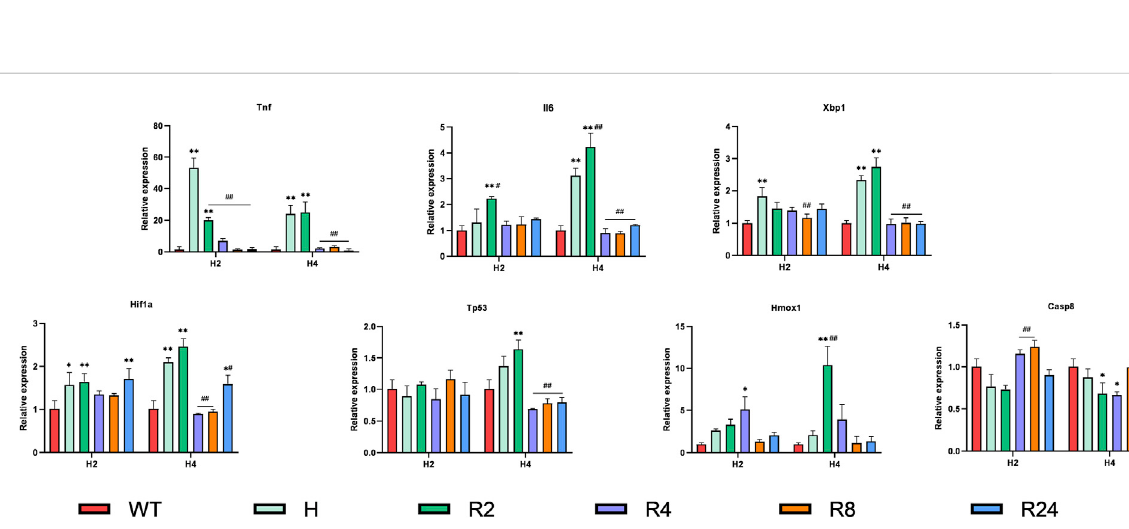
FIGURE 8 Expression levels of hub genes in hypoxia/reoxygenation models of H9C2 cells. H9C2 cells were hypoxic for 2 or 4 h and reoxygenated for 2 – 24 h, and the expression changes of hub genes were veri fi ed using RT-PCR. Data are mean ± standard derivation. One-way analysis of variance. *Compared with the control group, # Compared with the hypoxia group; */#, p < 0.05; **/##, p <